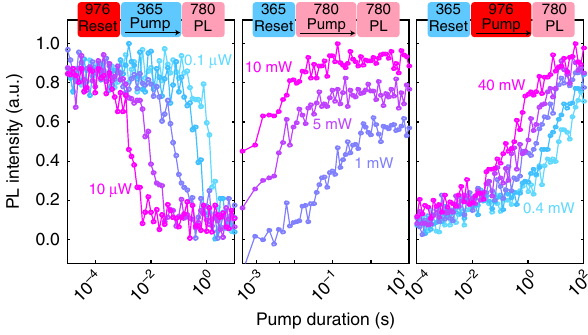
at 6 K. Reset-pump-measure scheme similar Fig. 5 Photo-dynamics of V (cid:1) Si to Fig. 3, but with 780 nm to excite PL in V (cid:1) instead of 976 nm for VV 0 . Si Each of the curves correspond to different pump powers (logarithmic increment for 365 and 976 nm). 365 nm reduces the PL intensity, likely from charge conversion to V 0 . Both 976 and 940 nm reinitialize VV toward Si its bright V (cid:1) state, but with different rates and power dependence, Si indicating charge transfer with VV. Charge conversion was measured to be persistent without light on the experiment timescales